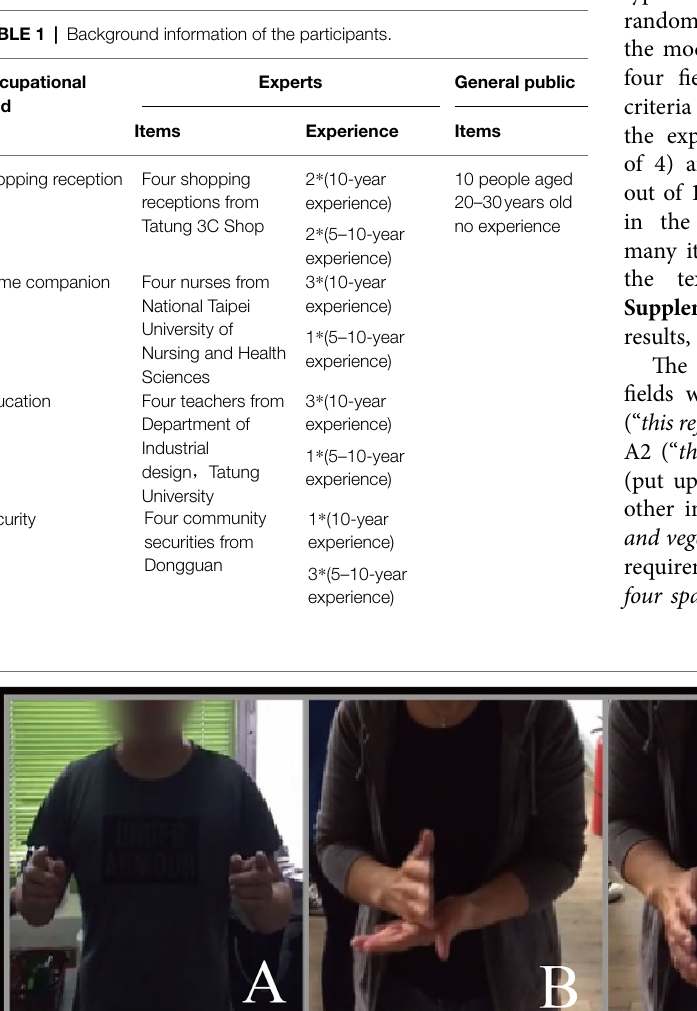
Observation and Extraction